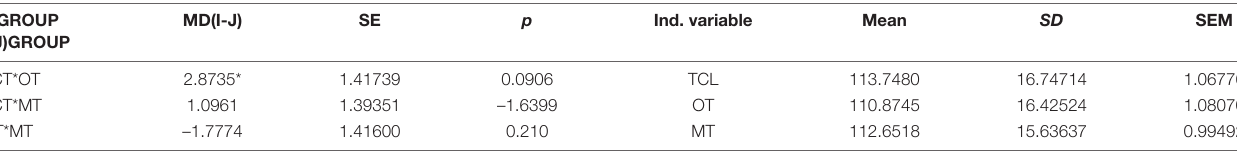
TABLE 3 | Comparison of learning motivation under various teaching modes.